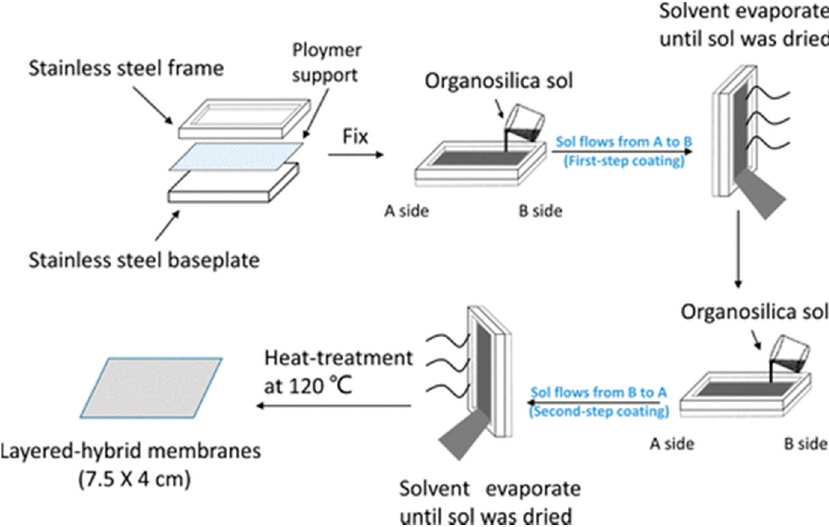
Figure 11. Schematic diagram for fabrication of organosilica/polymeric support membrane via the “flow-induced deposition” approach [111].